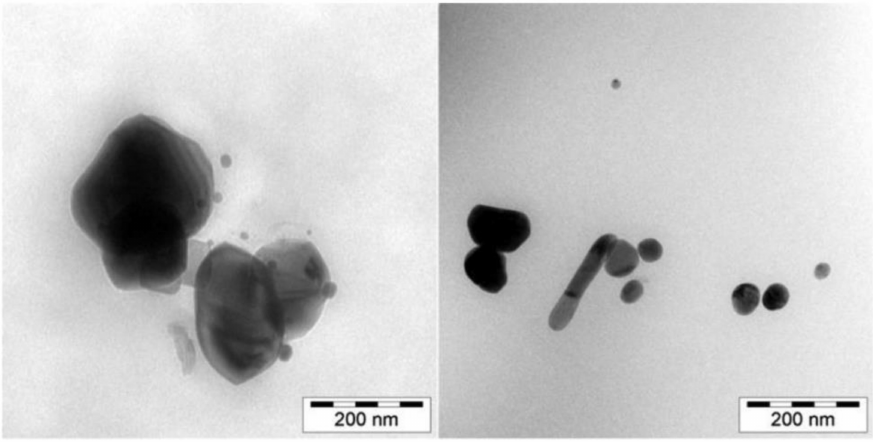
Figure 1. Transmission electron microscopy (TEM) images of an AgNPs-nanocomposite.